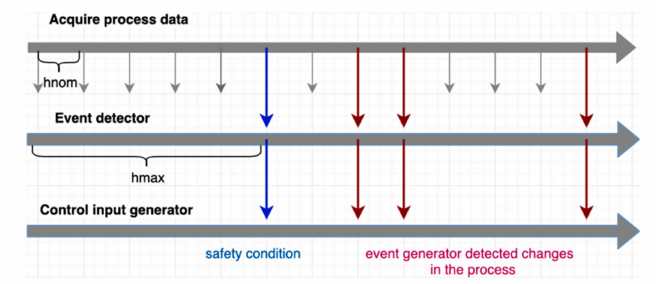
Figure 2. Basic paradigm of an event-based controller implementation